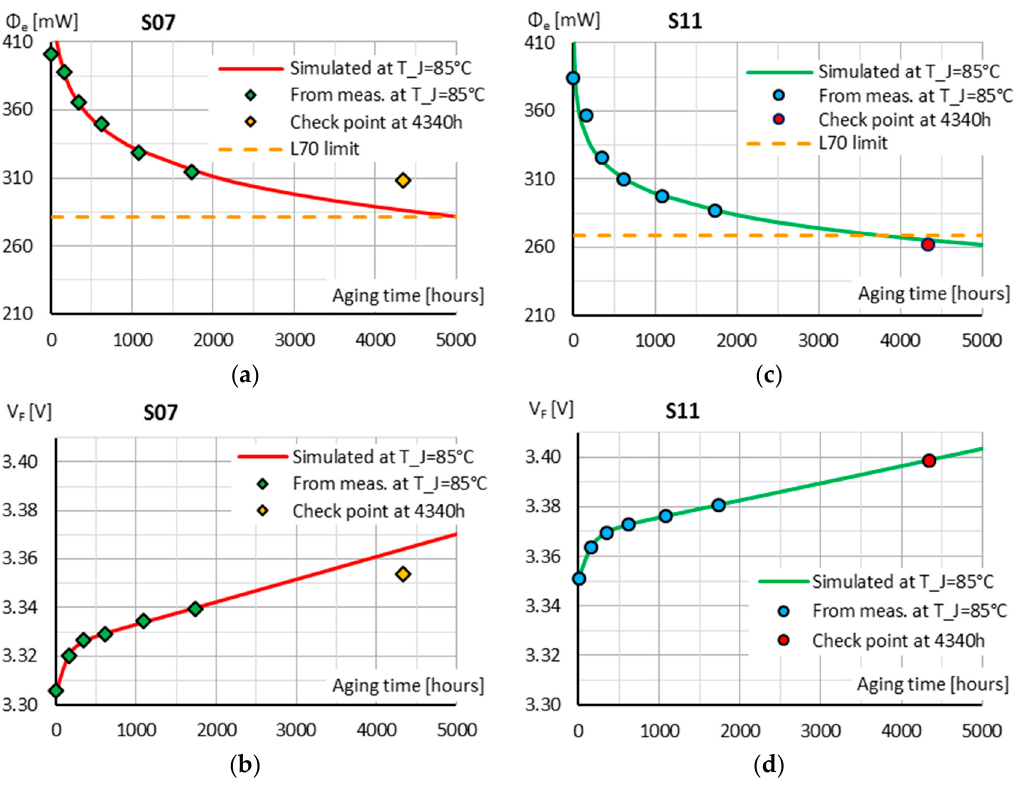
Figure 18. Simulated and measured total radiant flux maintenance of #S07 ( a ) and sample #S11 ( c ); Measured and simulated time function of the forward voltage of sample #S07 ( b ) and sample #S11 ( d ). Table 4. The error made by the model compared to the measurement results at 4340 h.